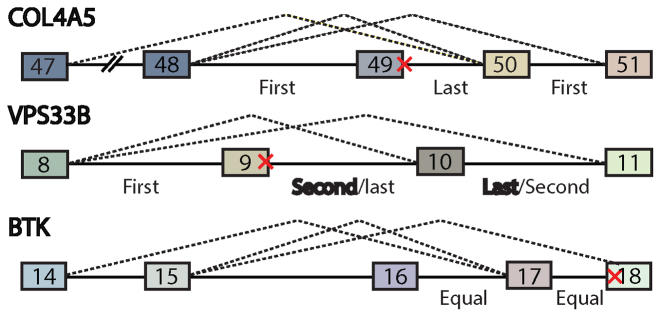
Introns proximal to the reported mutations splice last. Three cases where mutation caused multiple exon skipping were found on HGMD. Red x denotes location of reported mutation. Dashed line shows the reported splicing pathways. All cases led to disease. cDNA was synthesized from random 9mer selected HEK293 total RNA. In all cases, intron that is proximal to the mutation was the last one to be removed. In case of VPS33B, the major species removed intron 10 first. PCR amplification of intron 14 and 15 of BTK gene failed.